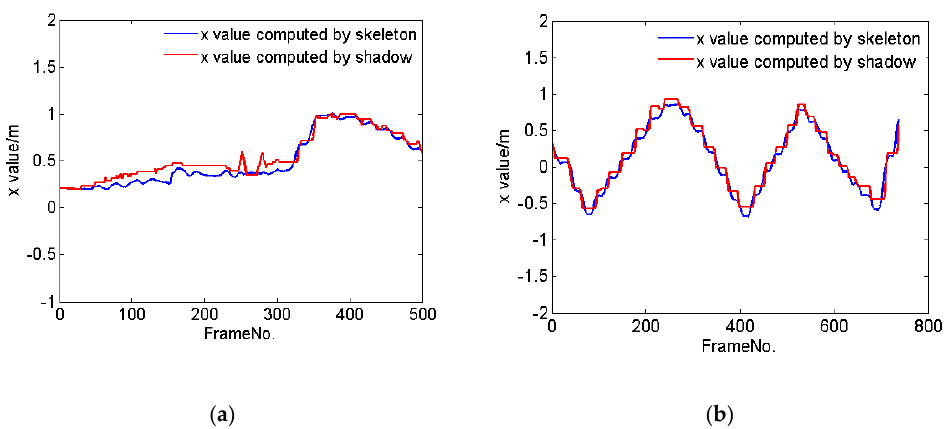
Figure 2. The trajectories of one person tracked by their skeleton (blue line) and shadow (red line), as the person walks along the X axis in the coordinate system of the Kinect ( a ) at various speeds, and ( b ) at a constant speed.